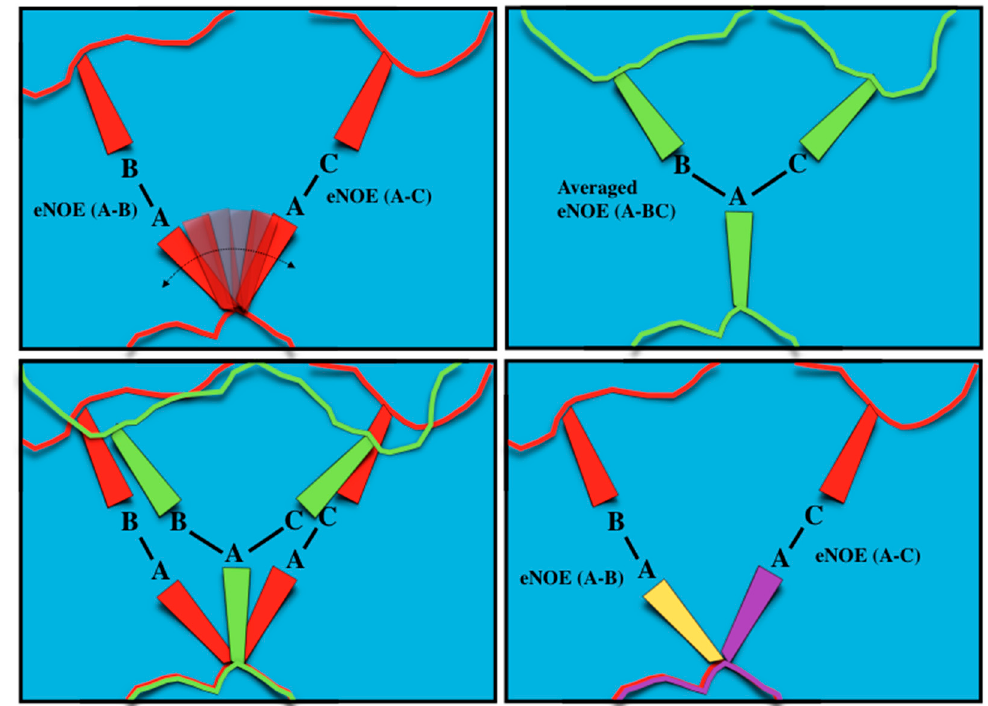
Figure 3. Schematic representation of single-state vs multiple-state eNOE structure calculation. ( Top, left ) A theoretical system of atoms A, B, and C within a protein. Atoms B and C are fixed at certain positions, while atom A exists in dynamic equilibrium, where it is in close proximity with both atom B and atom C; eNOEs would be measured between both atoms A and B as well as atoms A and C; ( Top, right ) The eNOEs measured appear to be from atom A interacting with atoms B and C at the same time. Assuming a single-state structure causes atom A to be placed directly between atoms B and C, and causes atoms B and C to be brought closer to atom A, distorting the calculated structure away from the true positions; ( Bottom, left ) Representation of how atoms A, B, and C in the calculated single-state structure (green) are distorted from their real positions (red); ( Bottom, right ) Allowing the structure calculation to employ multiple states (yellow and purple) allows atom A to occupy its true positions between atoms B and C, thus satisfying the eNOE-derived distance restraints and capturing important dynamics information.